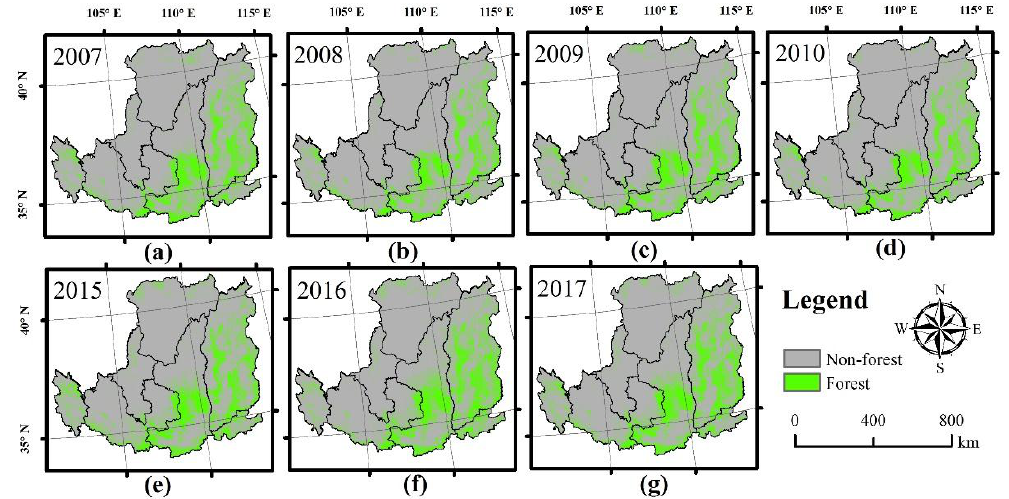
Figure 12. ( a – g ) Spatial distribution of forest cover in the Loess Plateau from 2007 to 2017 excluding 2011–2014 when the PALSAR data were unavailable.